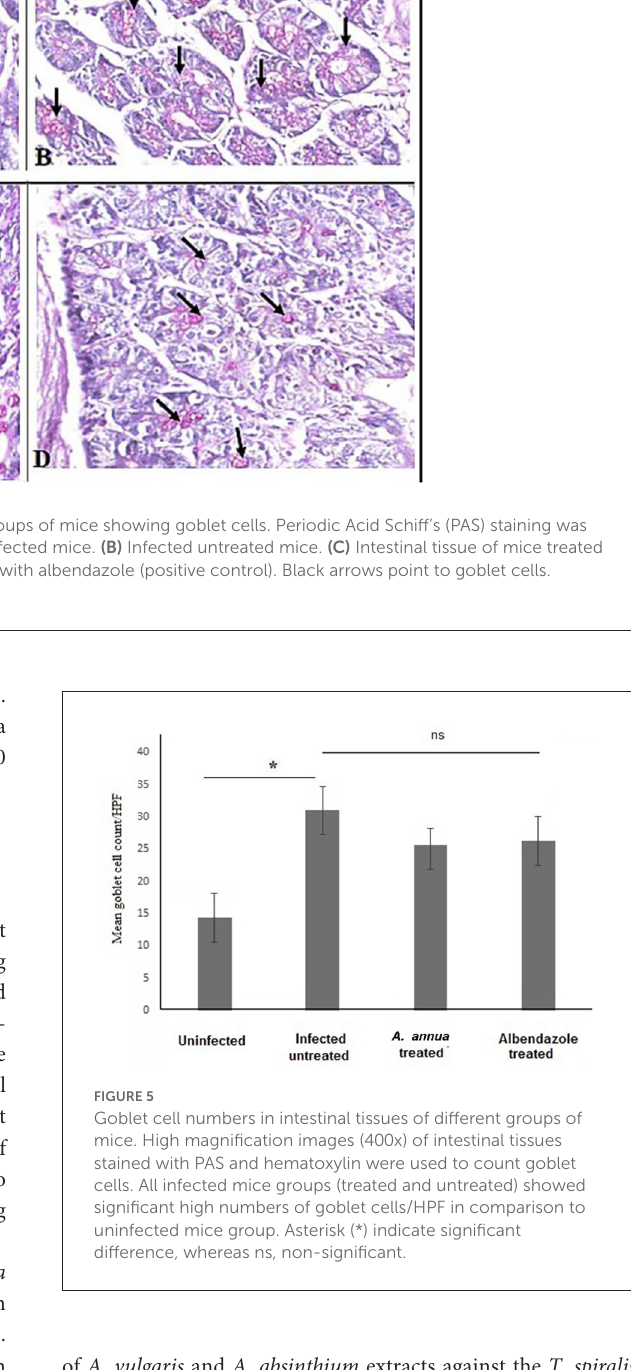
FIGURE5 Goblet cell numbers in intestinal tissues of different groups of mice. High magnification images (400x) of intestinal tissues stained with PAS and hematoxylin were used to count goblet cells. All infected mice groups (treated and untreated) showed significant high numbers of goblet cells/HPF in comparison to uninfected mice group. Asterisk (*) indicate significant difference, whereas ns,